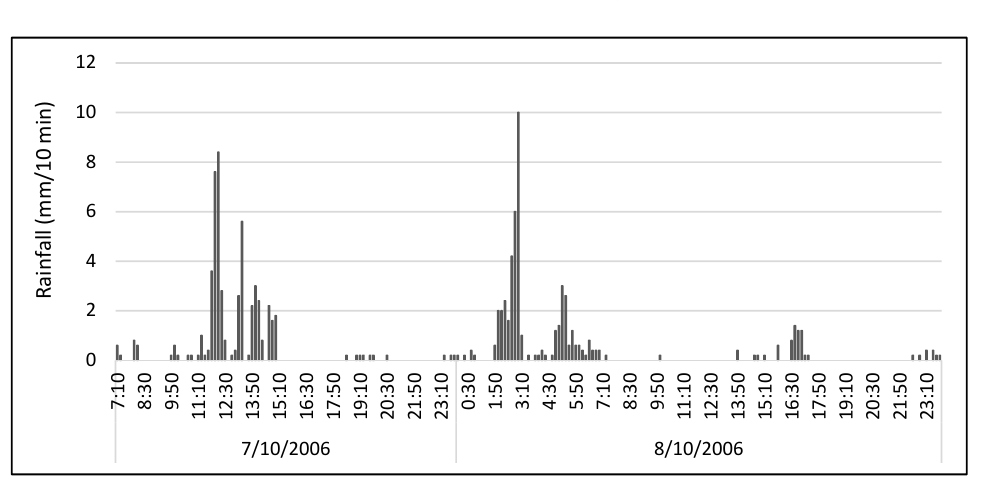
Figure 2. Rainfall intensity at Polygyros observatory during the October 2006 flood event.